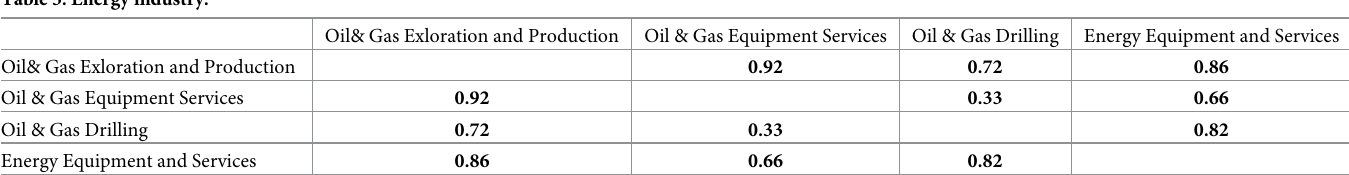
Table 5. Energy industry.